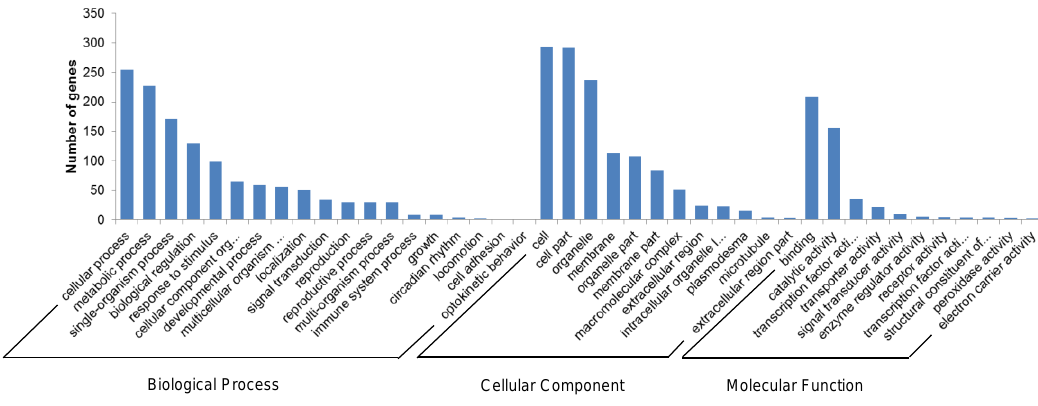
Figure 6. Gene ontology terms and numbers of the predicted miRNA targets.